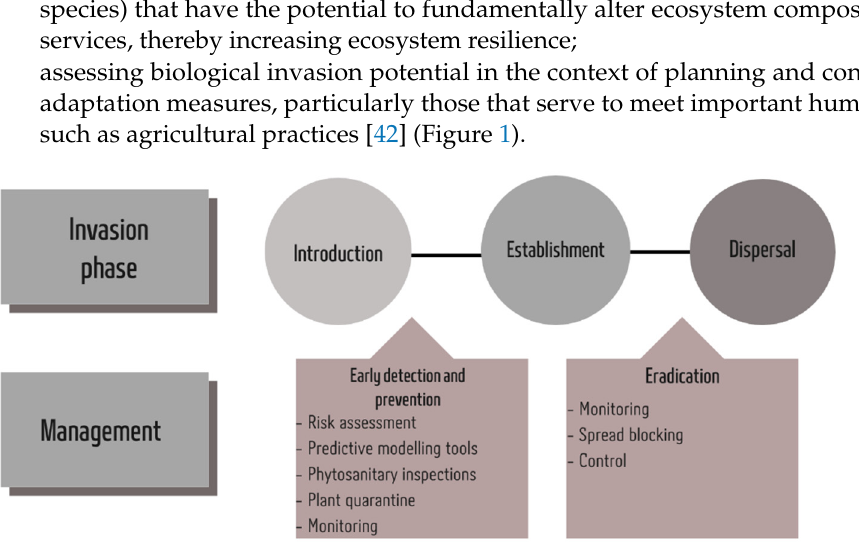
Figure 1. Schematic representation of strategies for the management of pest invasions.